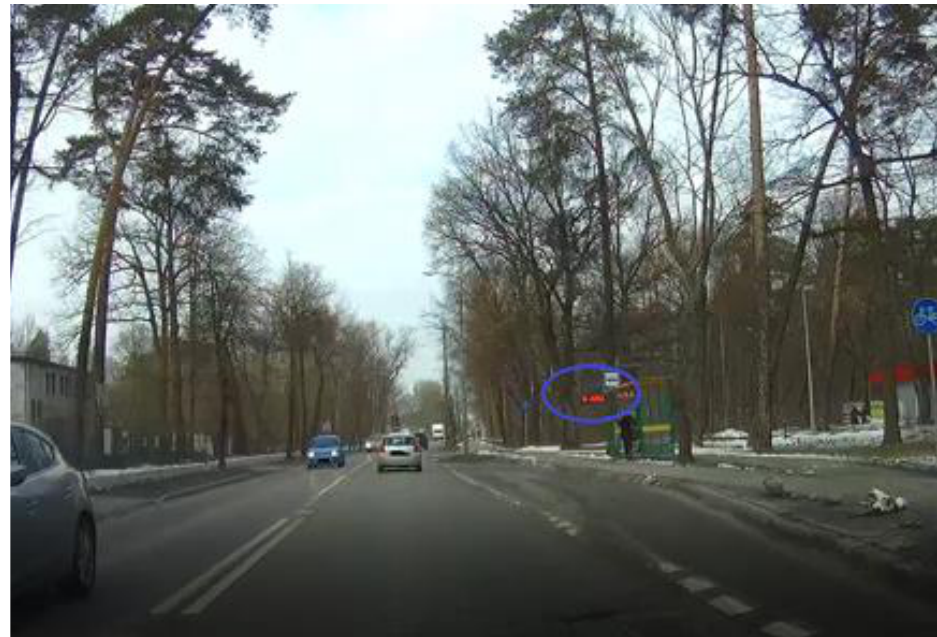
Figure 6. A photo of a double traffic light system. The blue oval indicates the red roadside adver- tisement (the authors’ own study).